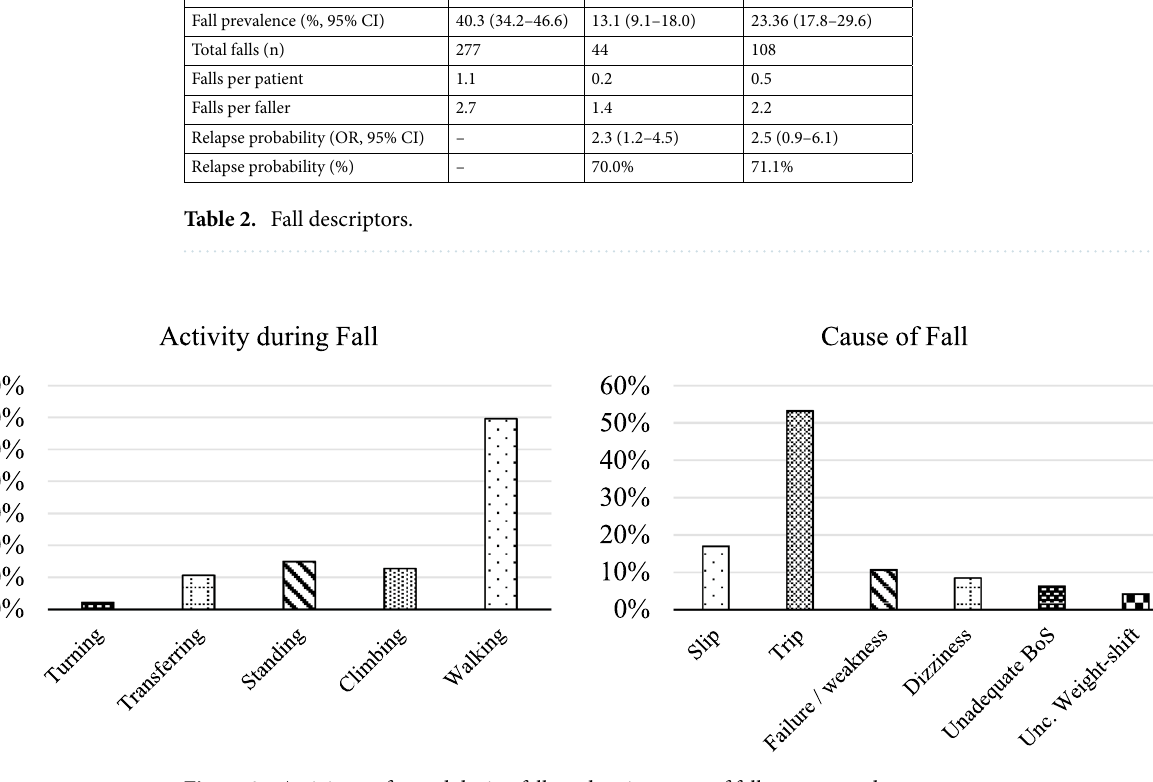
Figure 2. Activity performed during falls and main causes of falls represented as percentages.